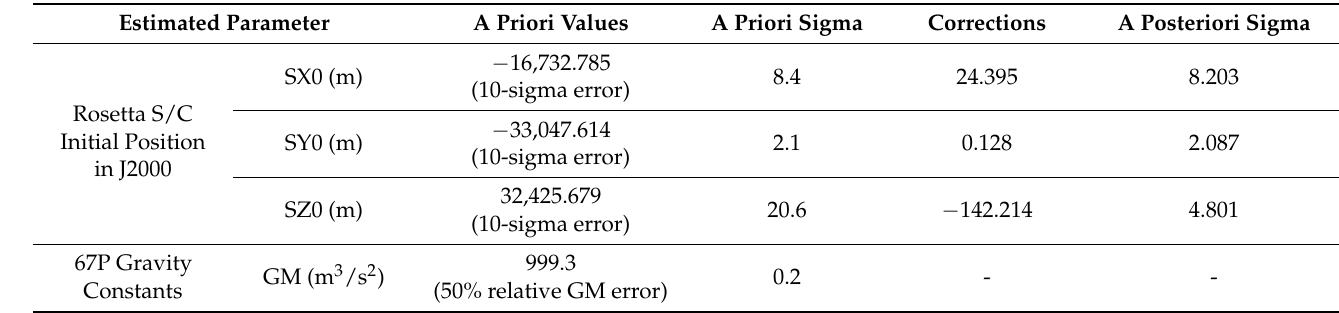
Table 11. Evaluation of navigation accuracy (case C). Parameter corrections and associated formal errors for the least-squares fit with a 50% relative error on the GM value (case C). Post-fit orbit residuals are given in Table 9, third column. The other parameters are kept constant to the values found in Tables 6 and